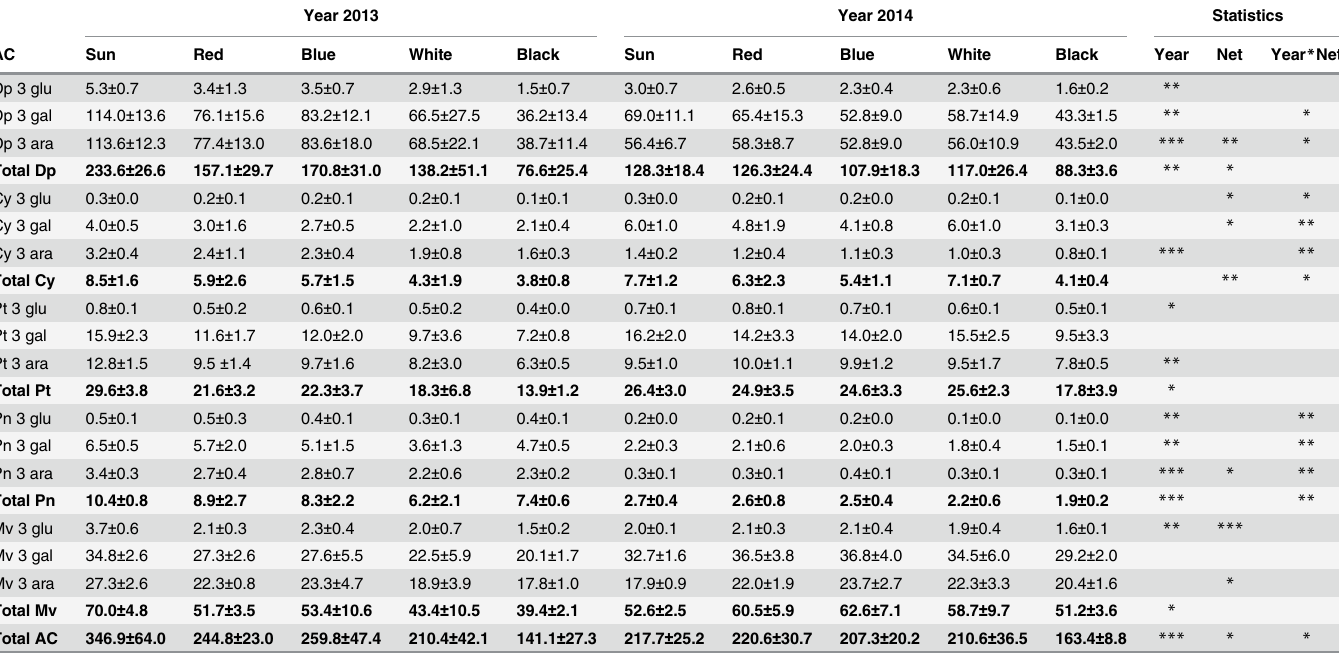
Table 3. List of anthocyanins (AC) identified in blueberries grown under different photo-selective nets during 2013 and